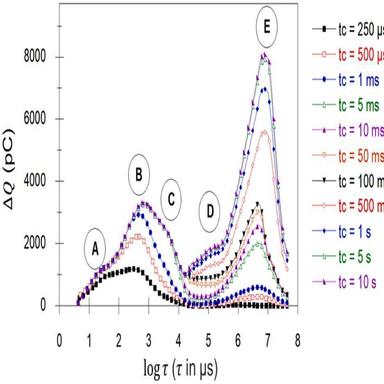
Q-DLTS spectra in an ITO/PEDOT/(PF-N-PH)/Al diode for different charging times tc at T = 300 K.